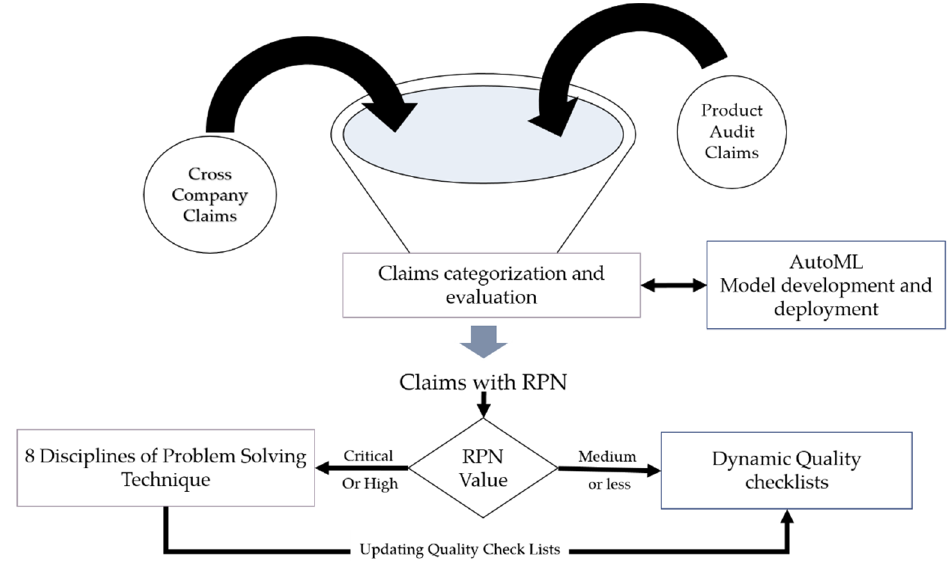
Figure 4. The flow of internal quality audit and cross-company claims to quality management.